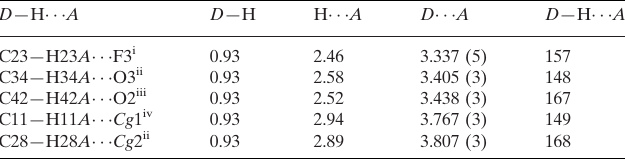
Hydrogen-bond geometry (A˚ , (cid:2)